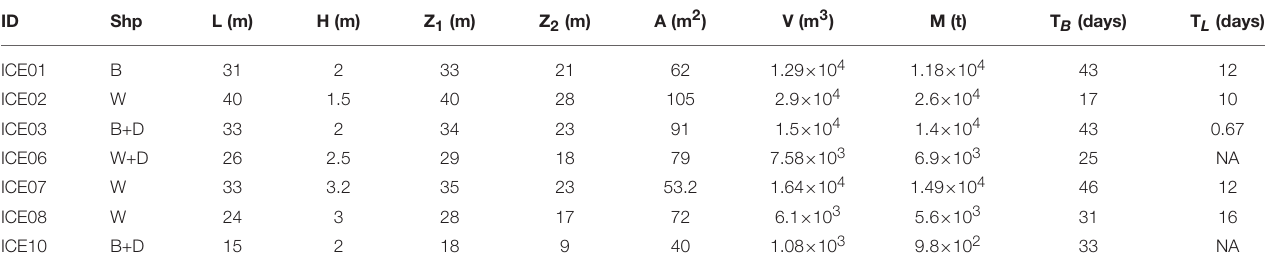
TABLE 1 | Shape and estimated dimensions of icebergs tagged with EXITE